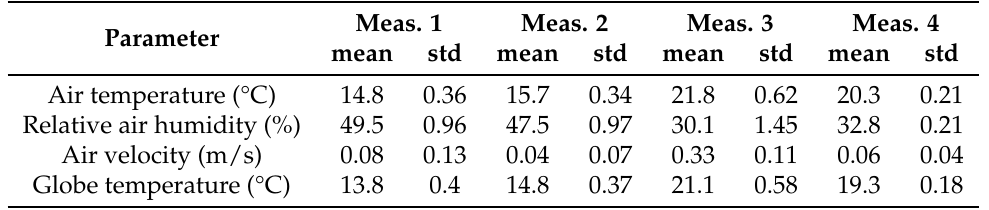
Table 8. Mean values and standard deviations of the measured climatic parameters over the mea- surement